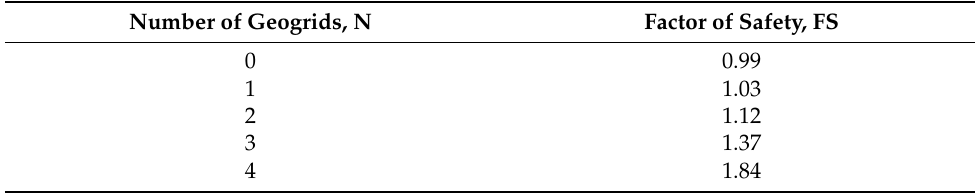
Table 8. FEM analysis results for the reinforced slope (1V/2H slope, N = 4). Number of Geogrids, N